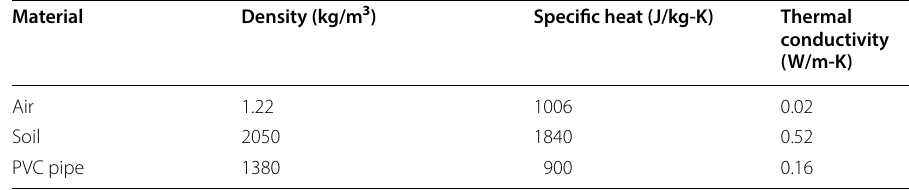
Table 1 Material properties used in simulation